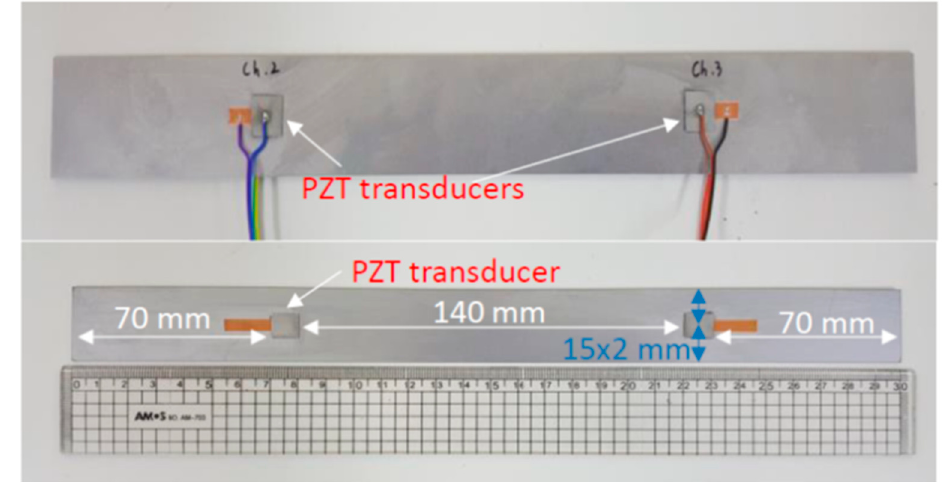
Figure 2. Piezoelectric (PZT) transducer locations on plate, including dimensions.